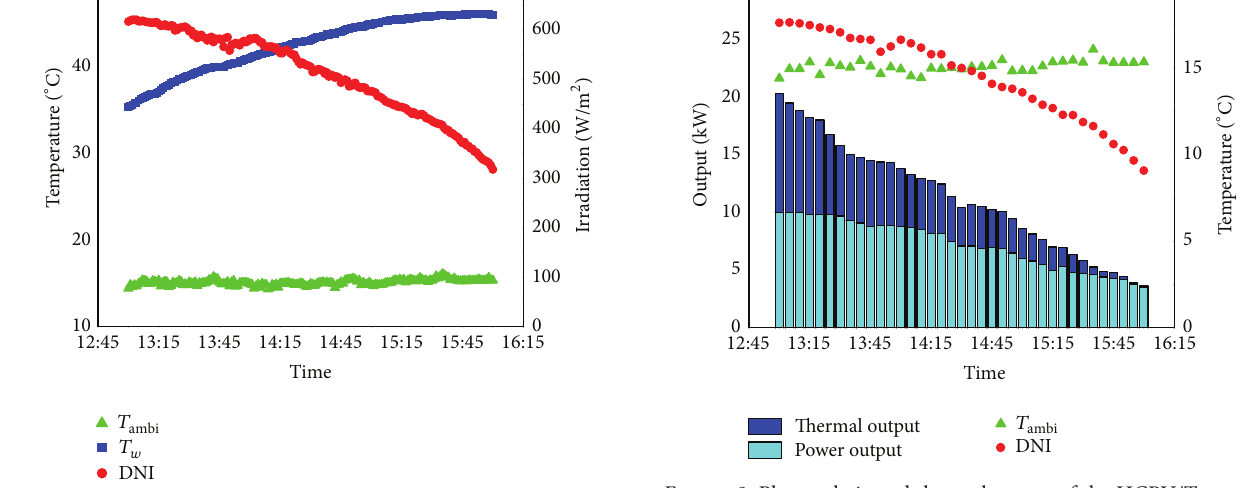
Figure 7: Environmental parameters in the testing period.